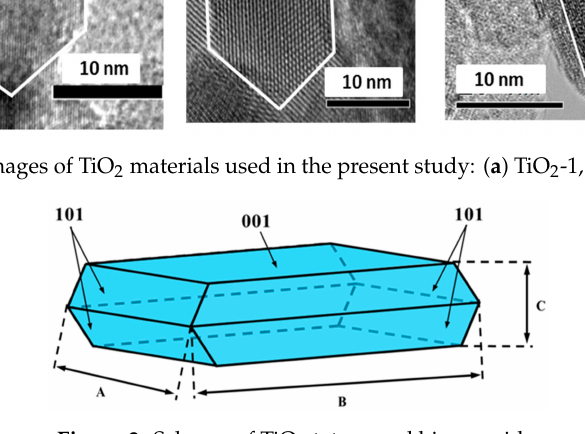
Figure 3. Scheme of TiO 2 tetragonal bipyramids. Table 1. Texture, nanocrystals’ shape characteristics, and % exposure of (001) planes in TiO 2 samples used in the present